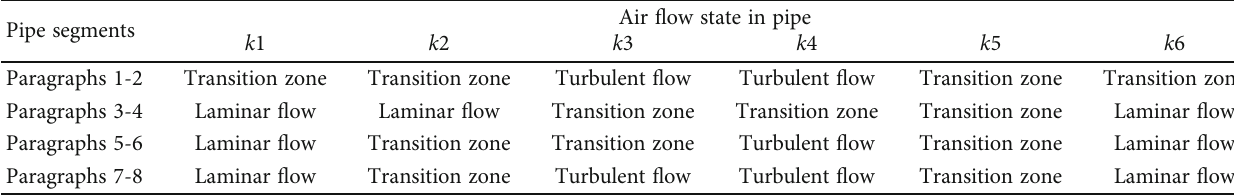
Table 4: Air fl ow state in tube of transverse type (10m 3 /h).